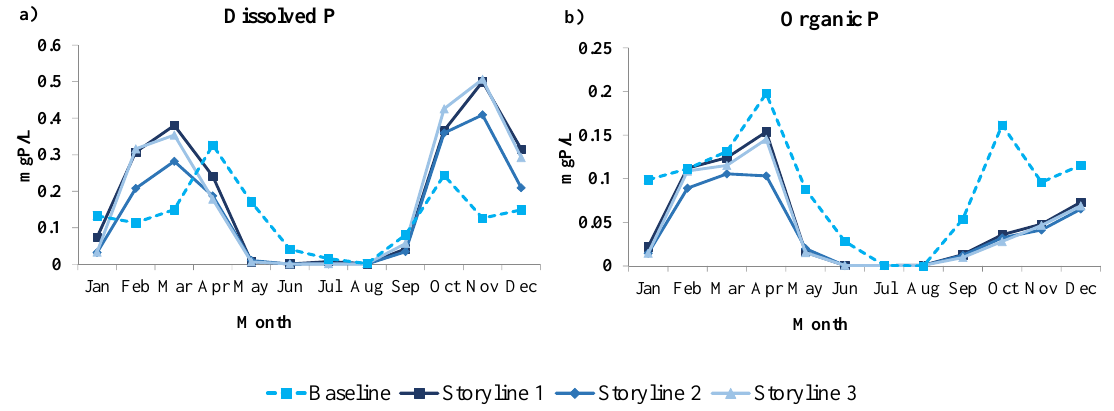
Figure 11. The monthly evolution of the P forms (mg P L − 1 ) for each storyline (timeline 2060 and GFDL climate model) and baseline: ( a ) Dissolved P; and ( b ) Organic P.